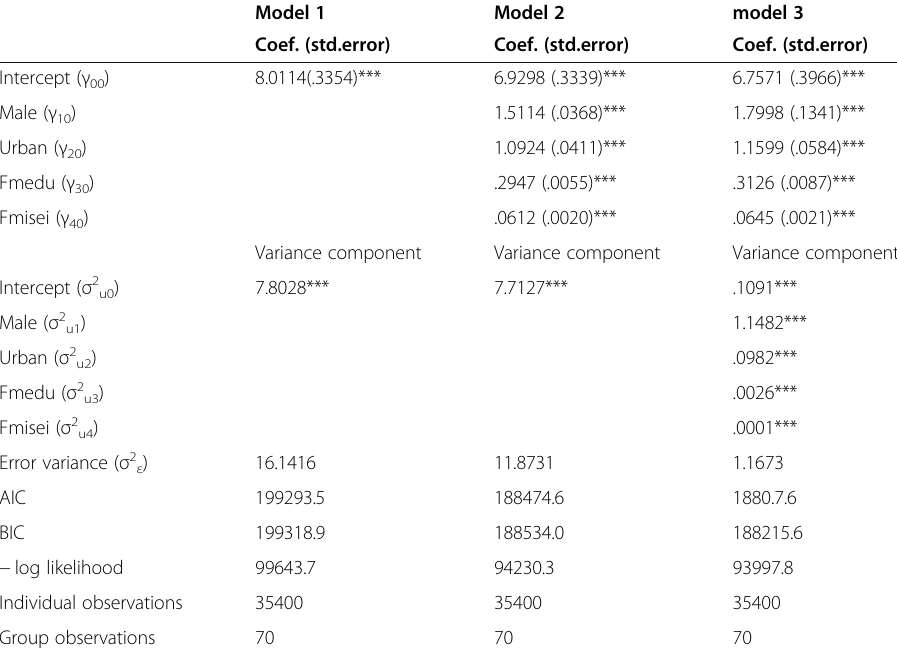
Table 2 Multilevel linear regression on respondents ’ years of education Model